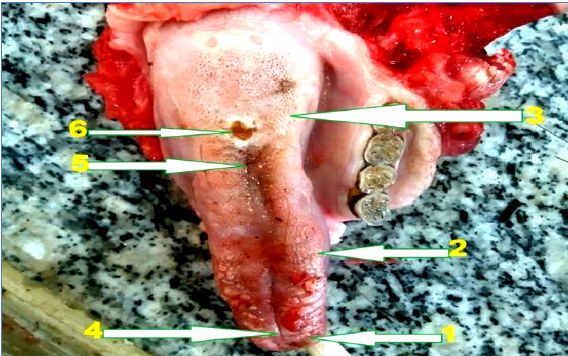
Figure, 1: Morphological of tongue show: Apex (1) corpus (2) root (3) midline sulcus (4) lingual fossa (5) tourus lingue (6).